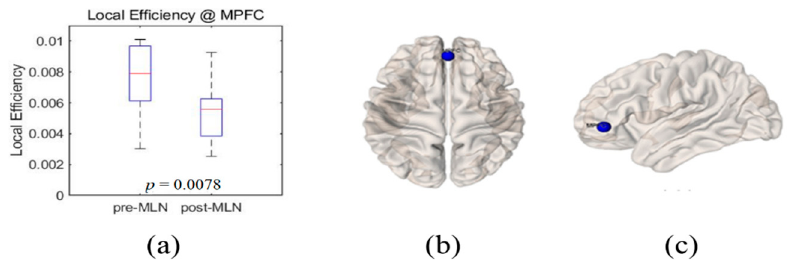
Figure 3. Illustrations of local efficiency change at medial prefrontal cortex (mPFC) as the functional connectivity of neural networks in fibromyalgia patients’ brains due to Milnacipran drug therapy. ( a ) Boxplots (left: before medication, right: after medication) of local ‐ efficiency ‐ index distributions at mPFC site. Blue markers indicate this position on the 3D brain surface in ( b ) transverse and ( c ) lateral views. The blue color of the markers implies that the local ‐ efficiency index statistically decreased due to drug therapy.